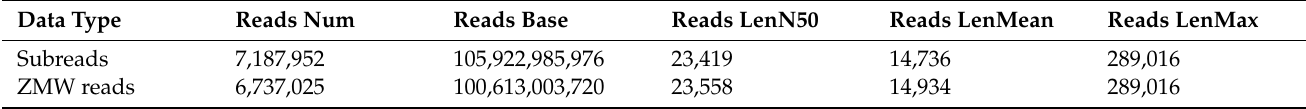
Table 1. Summary of the Bemisia tabaci MED genome assembly.